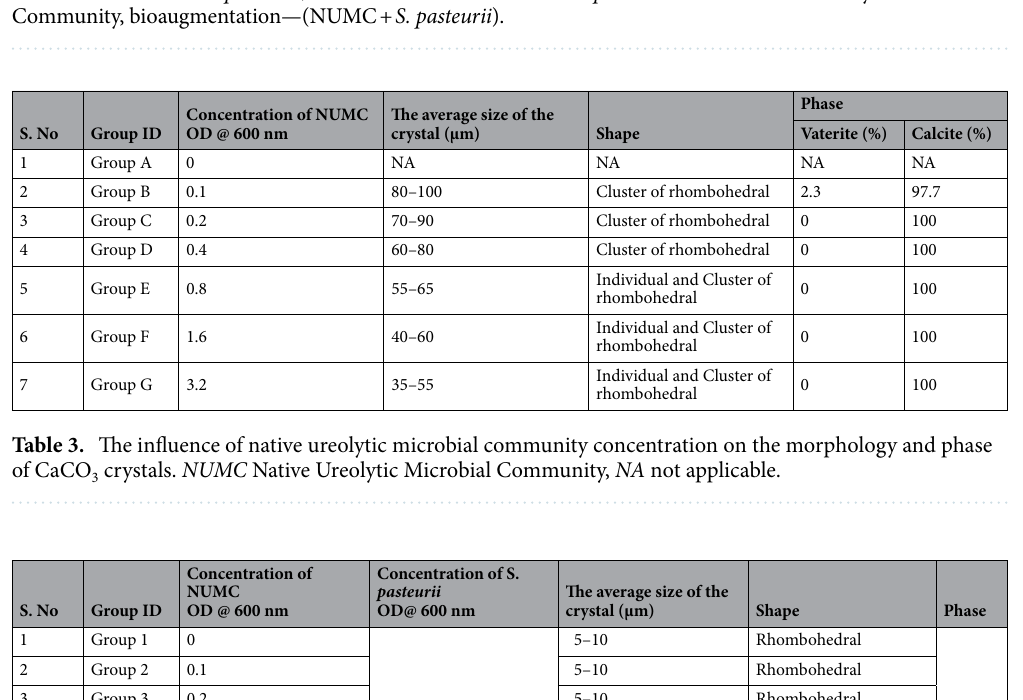
Figure 4. XRD spectrum of CaCO 3 polymorphs. (a) Group B (NUMC) and (b) Groups C to G (NUMC) and 1 to 7 (bioaugmentation). Group B—0.1 OD NUMC, Group C—0.2 OD NUMC, Group D—0.4 OD NUMC, Group E—0.8 OD NUMC, Group F—1.6 OD NUMC, and Group G—3.2 OD NUMC. Group 1—0 OD NUMC + 0.4 OD S . pasteurii , Group 2—0.1 OD NUMC + 0.4 OD S . pasteurii , Group 3—0.2 OD NUMC + 0.4 OD S . pasteurii , (4) Group 4—0.4 OD NUMC + 0.4 OD S . pasteurii , 0.8 OD NUMC + 0.4 OD S . pasteurii , 1.6 OD NUMC + 0.4 OD S . pasteurii , and 3.2 OD NUMC + 0.4 OD S . pasteurii . NUMC Native Ureolytic Microbial